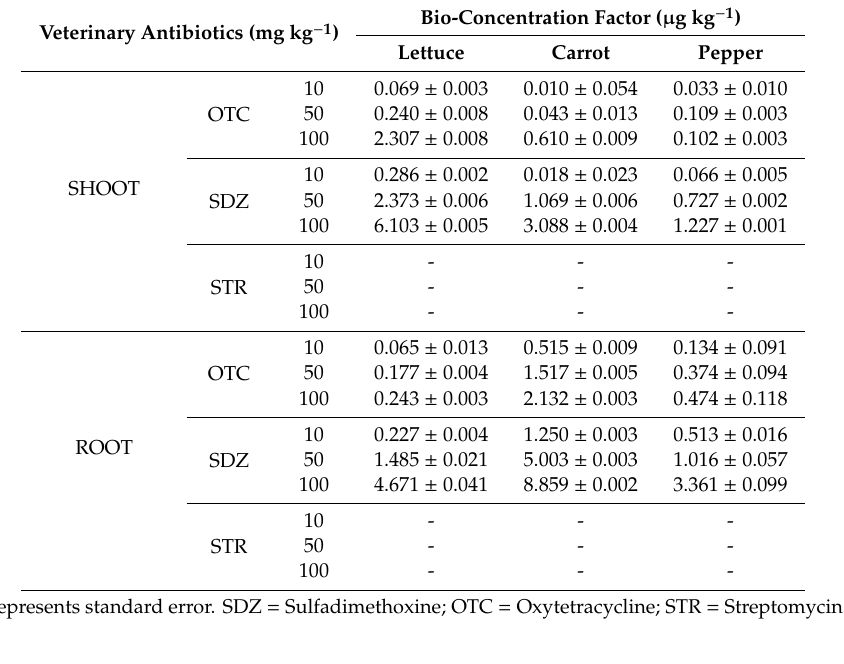
Table 5. Bioconcentration factor (BCF) values of lettuce, carrot and pepper plants grown in soil treated with VAs.